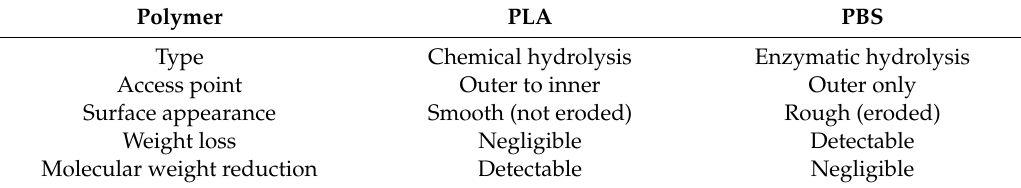
Table 5. The first stage of biodegradation of PLA and PBS, adapted from [64]. Reprinted from Polymers for Advanced Technologies, Volume 8, Mochizuki, M.; Hirami, M., Structural E ff ects on the Biodegradation of Aliphatic Polyesters, 203-209, Copyright © 1997, with permission from John Wiley and